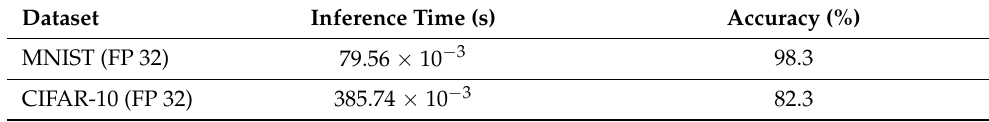
Table 4. Inference Times on the CPU.